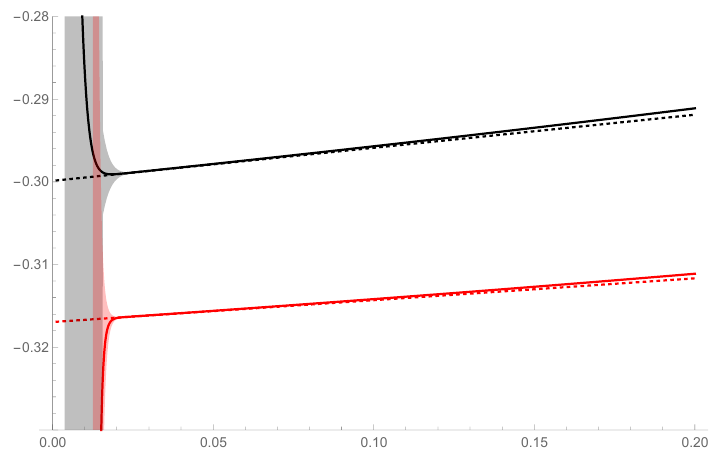
Figure 5 . We plot an approximation to f ( α ) , defined in (3.75), for the Gross-Neveu model with N = 7 (black) and N = 8 (red). The shaded areas represent the error of the corresponding color and the dashed lines represent the asymptotic behaviour for α (cid:28) 1 in (3.75). For this plot we truncated the energy series at 71 coefficients, calculated numerically with at least 400 digits of precision, and used a [35 / 35] Padé